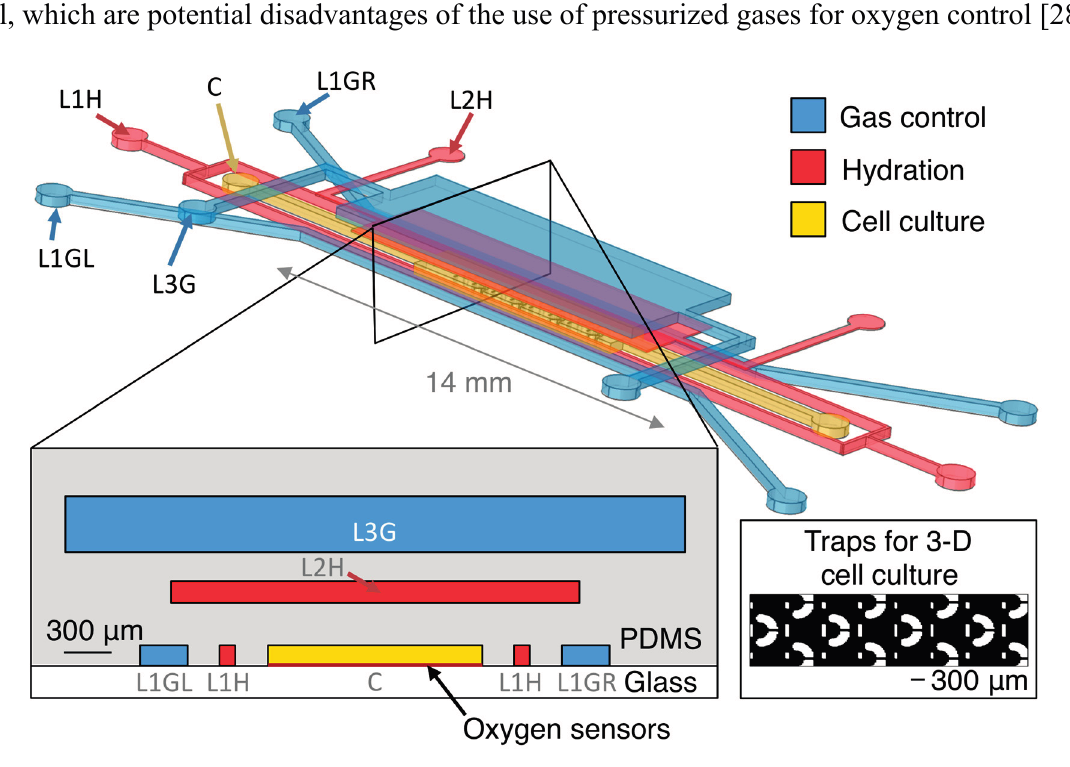
Figure 1. Oxygen control microfluidic device layout, showing 3-D and cross-sectional views of the device as well as the position of the integrated optical oxygen sensors within the cell culture channel. The cell culture channel (C) is surrounded on three sides by gas control channels (L1GL, L1GR, and L3G), with hydration/bubble removal channels (L1H, L2H) between each of the gas channels and the centre channel. Inset shows trapping structures for 3-D cell cultures within the cell culture channel. Please note that the 3-D view is not to scale (microfluidic layers are spaced farther apart in the illustration than in the device to permit visualization of the three layers). Cross-sectional view is to